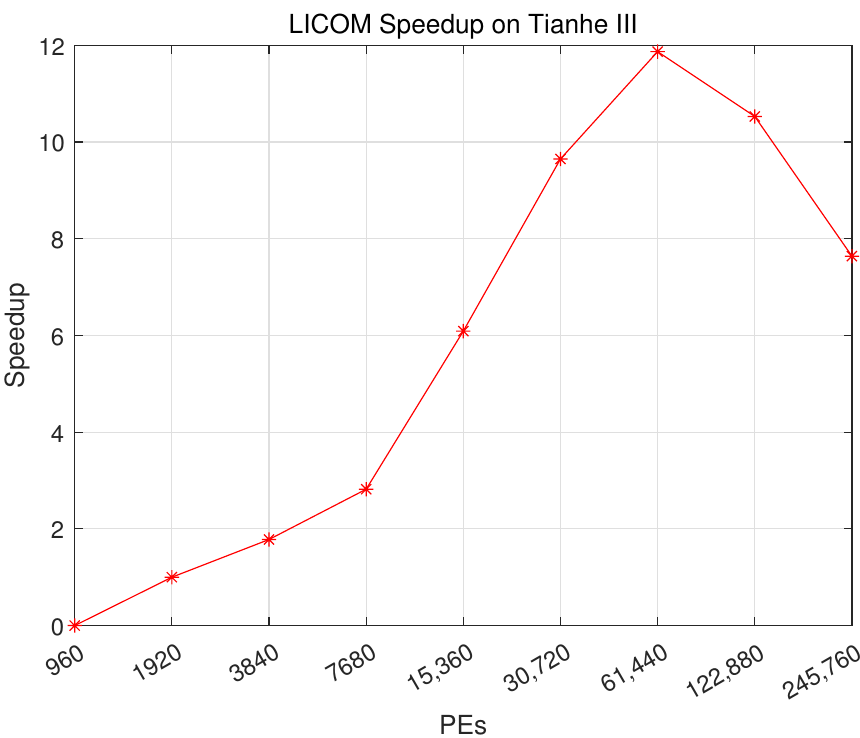
Figure 11. Speedup of LICOM on Tianhe